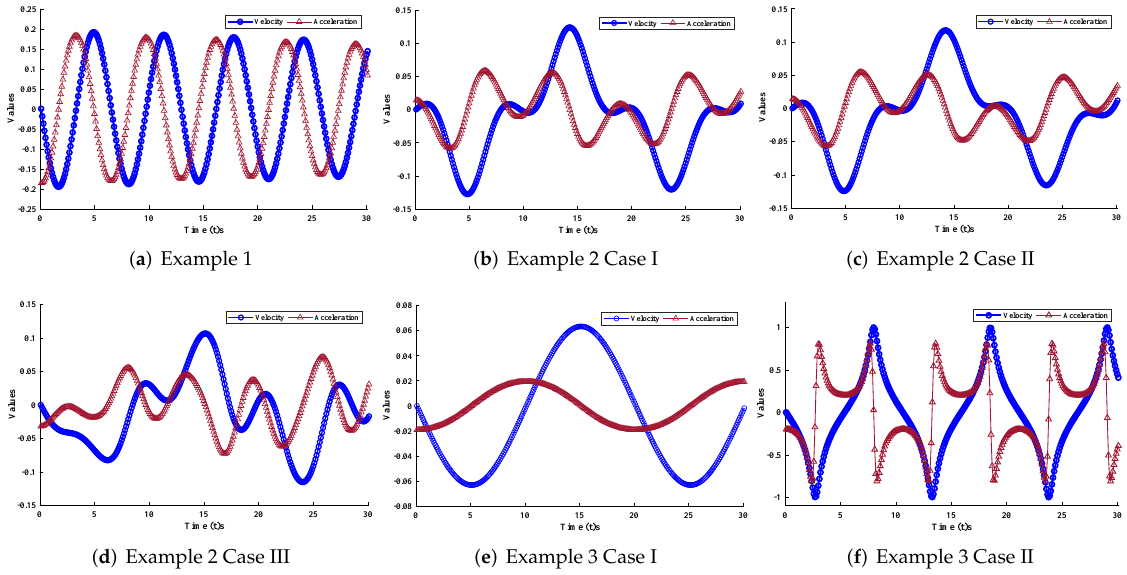
Figure 7. Plots of velocity ˙ x ( t ) and acceleration ¨ x ( t ) for different cases of the cubic damping motion of ships in random beam seas.